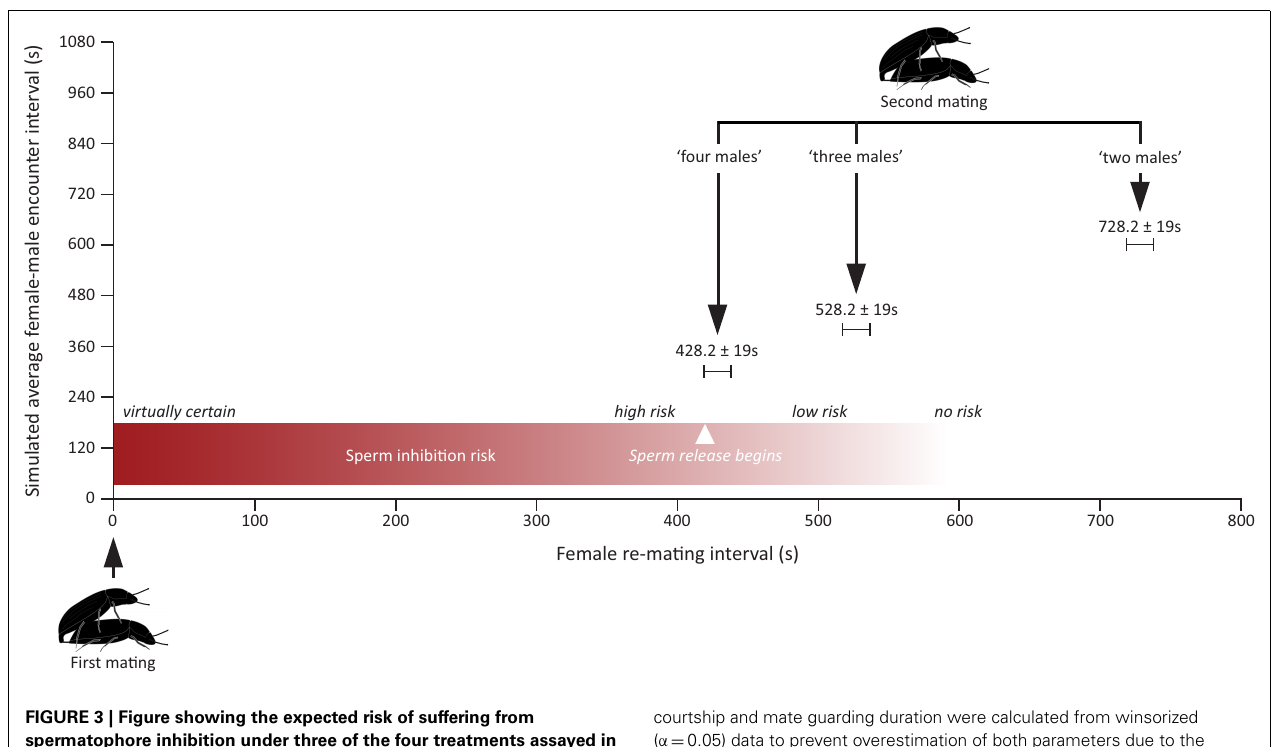
FIGURE 3 | Figure showing the expected risk of suffering from spermatophore inhibition under three of the four treatments assayed in this study. Expected female re-mating interval was calculated by summing up the average encounter rate with a new male simulated in each treatment (i.e., a novel male is encountered once every 1200s in the “one male” treatment, once every 600s in the “two male” treatment, once every 400s in the “three males” treatment, and once every 300s in the “four males” treatment) with the mean duration (mean ± SEM) of mate guarding and courtship taken from the “one male” treatment (i.e., 128.2 ± 19s). Average